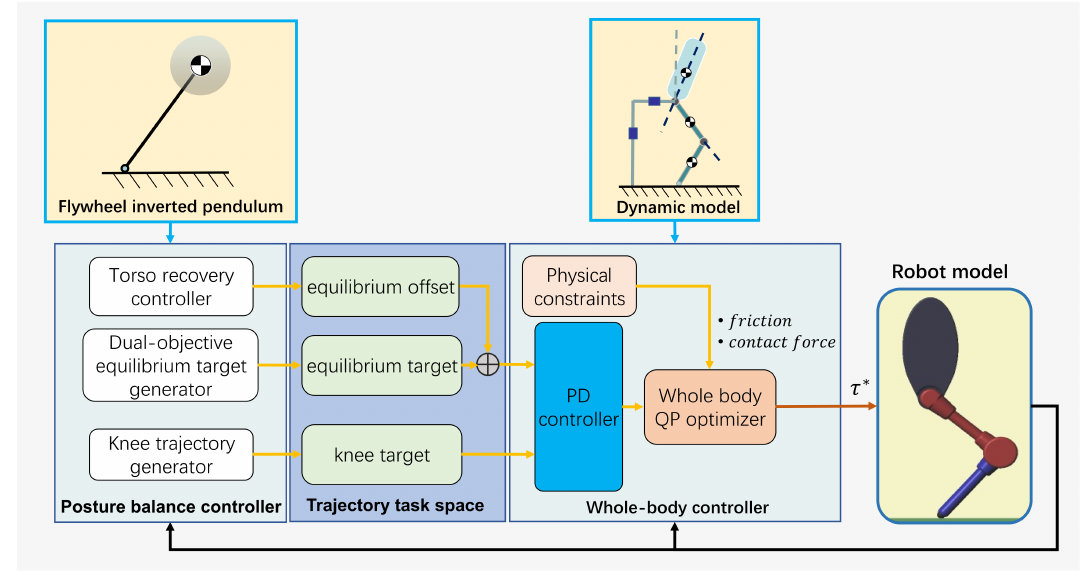
Figure 1. Block diagram of the balance control framework. τ ∗ is the optimized joint